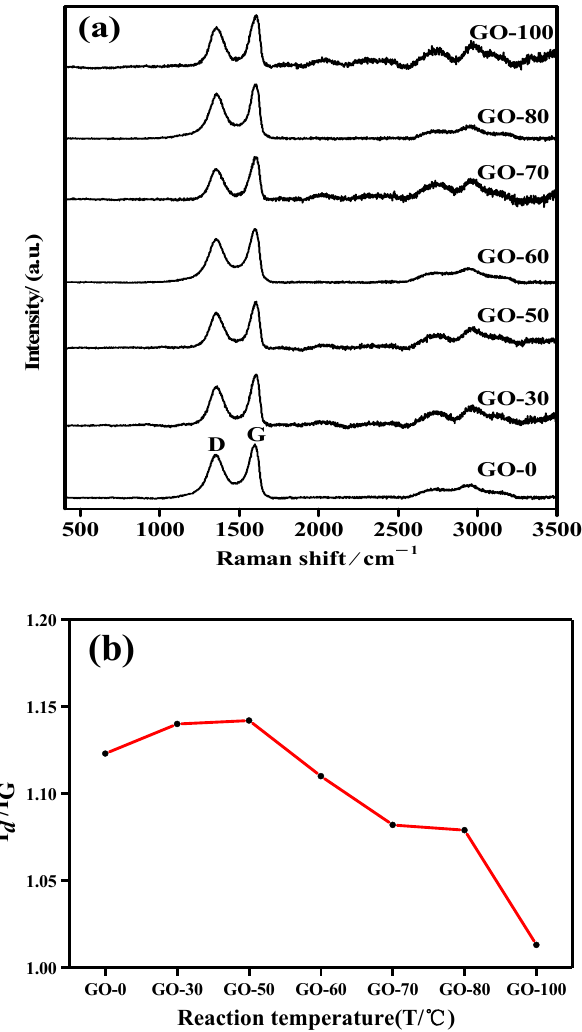
Figure 6. Raman spectrum and D/G peak ratio curve of graphite oxide samples prepared at different reaction temperatures: ( a ) Raman spectrum, ( b ) D/G peak ratio.